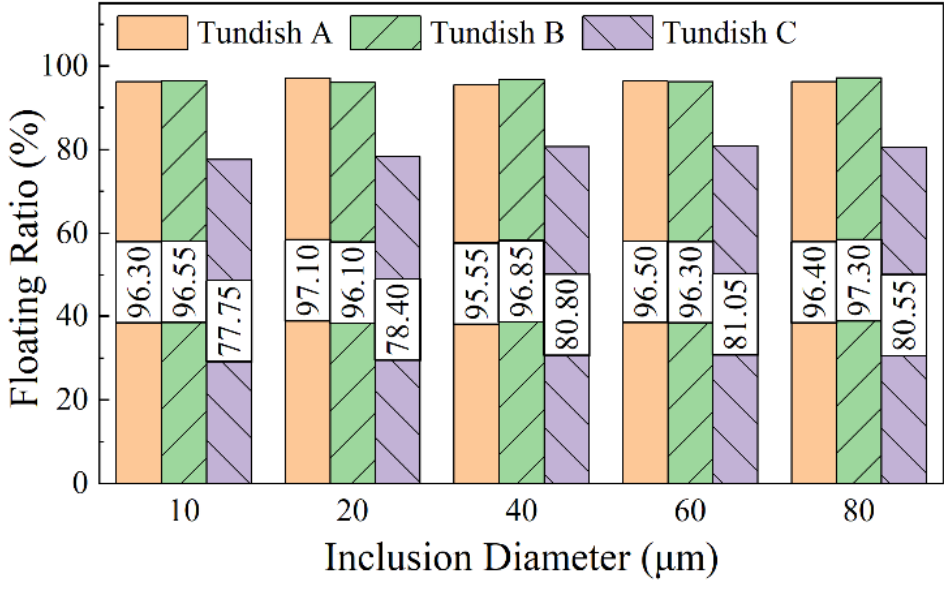
Figure 17. Floating ratios of inclusions in distributing chamber.